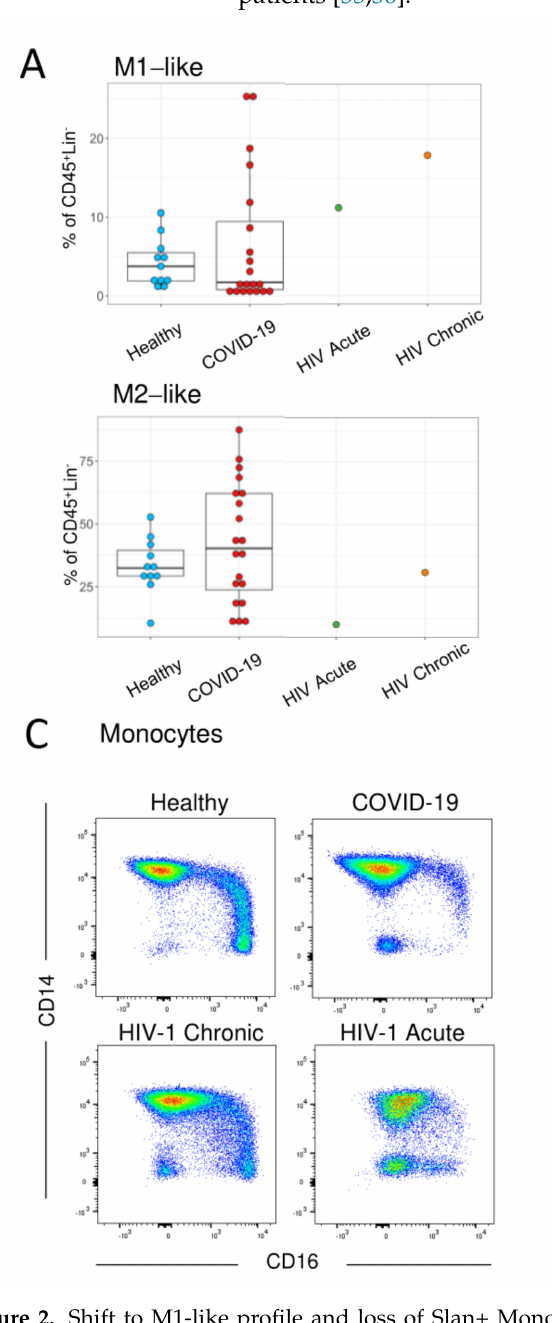
Figure 2. Shift to M1-like profile and loss of Slan+ Monocytes in acute HIV-1 infection. ( A , B ) Boxplots showing the frequencies and the medians of the identified subsets using FlowSOM, as shown in Figure 1. Each dot represents one subject. ( C , D ) Illustrative dot plots of the manual analysis performed in representative individuals from the healthy control and COVID-19 groups, as well as in the HIV-1 acute and untreated HIV-1 chronic patients showing the expression of CD14 and CD16 in monocytes ( C ); and the expression of HLA-DR and Slan in the non-classical (CD14 low/ − CD16 + ) monocytes ( D